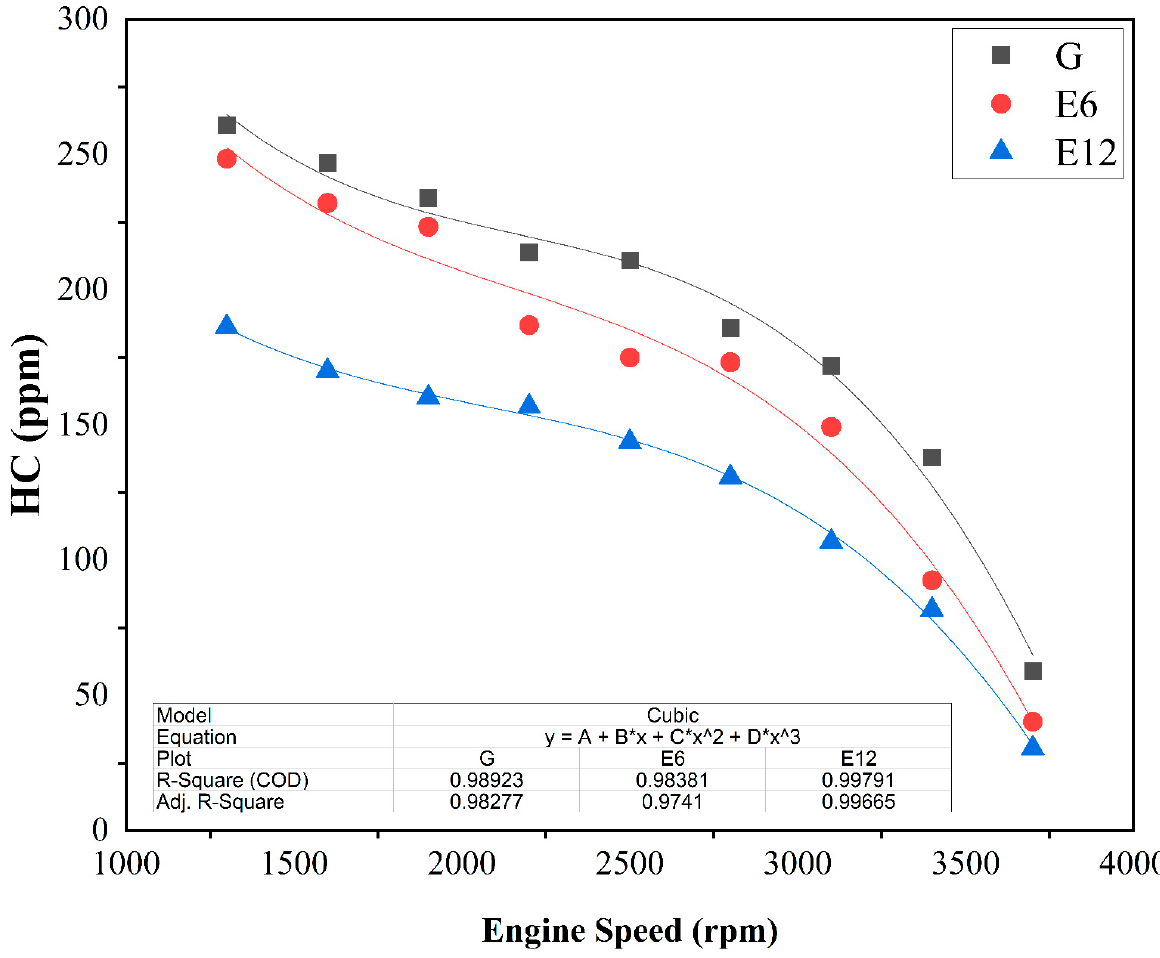
Figure 8. HC variation with engine speed.